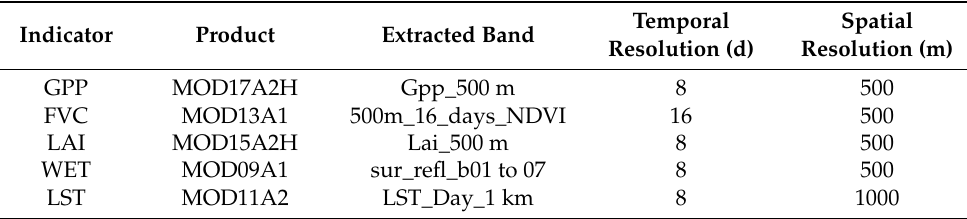
Table 1. Research indicators and MODIS data